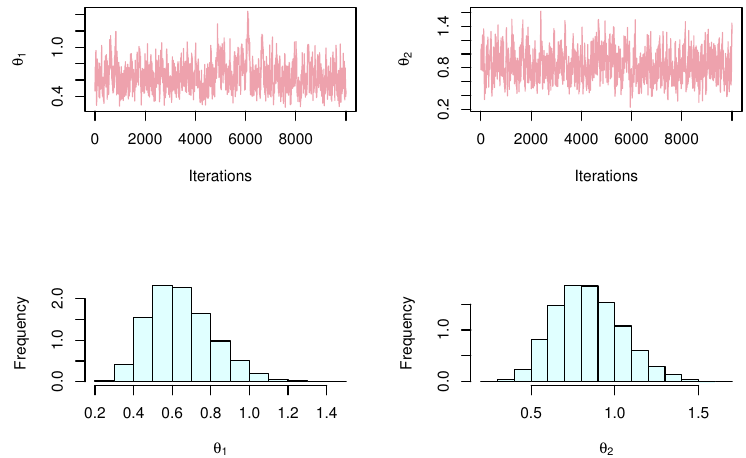
Figure 7. MCMC plot of parameter estimation by RSS method for banking